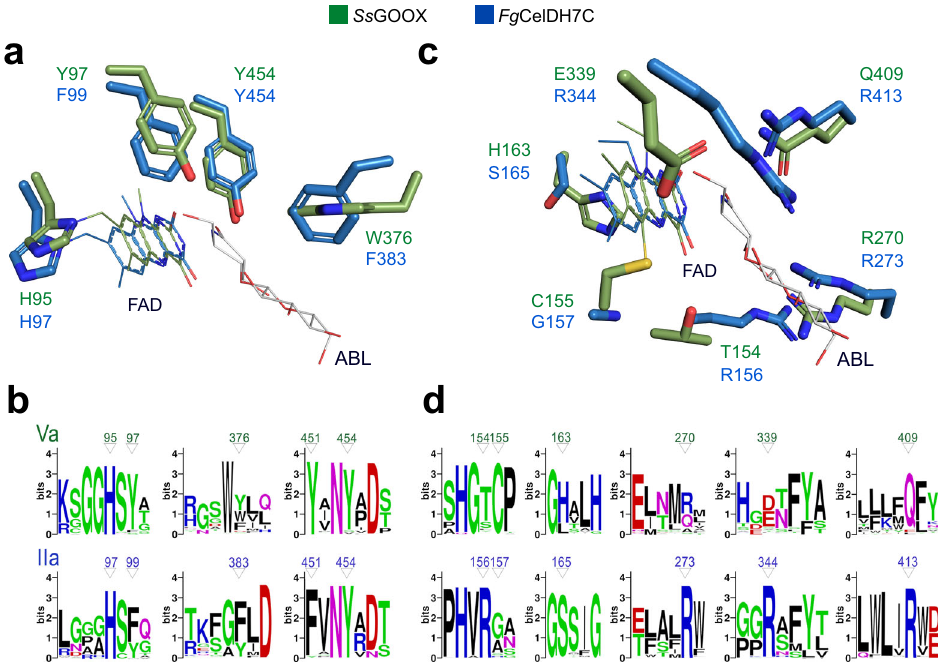
Fig. 3 Active site signatures of AA7 oligosaccharide oxidases versus dehydrogenases. The active sites of the clade IIa discovered dehydrogenase Fg CelDH7C (PDB: 6YJI) and the canonical clade Va cellooligosaccharide oxidase Ss GOOX (in complex with 5-amino-5-deoxy-cellobiono-1,5-lactam ABL, PDB: 2AXR) are shown. a The FAD-tethering histidine in addition to an aromatic cluster comprising the tyrosine base catalyst, a phenylalanine/tyrosine and the substrate-stacking aromatic residue are conserved features in fungal oligosaccharide dehydrogenases and oxidases. b Sequence logos of patches spanning the structurally similar active site residues shown in ( a ). c Active site differences between clades IIa and Va. d Sequence logos of patches spanning the structurally divergent active site residues shown in c from clades IIa and Va. The amino acid numbering of the deposited protein sequences is used in the fi gure.